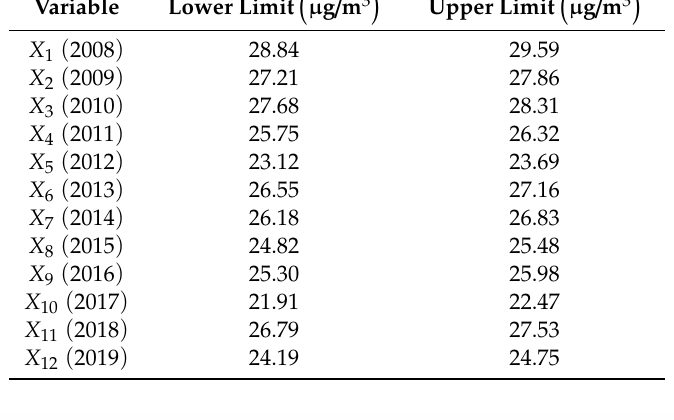
Table 2. Confidence interval limits for the median, with α = 0.05